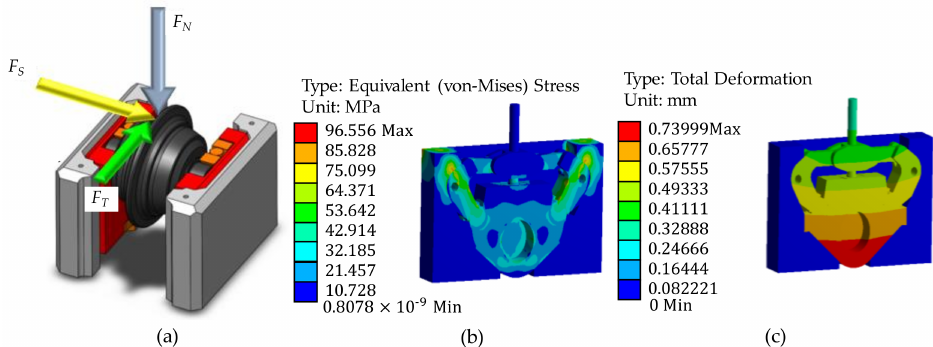
Figure 6. Static stress analysis. ( a ) Schematic diagram of the force directions; ( b ) The maximum stress of finite element analysis of the ICS; ( c ) The maximum deformation of the ICS.